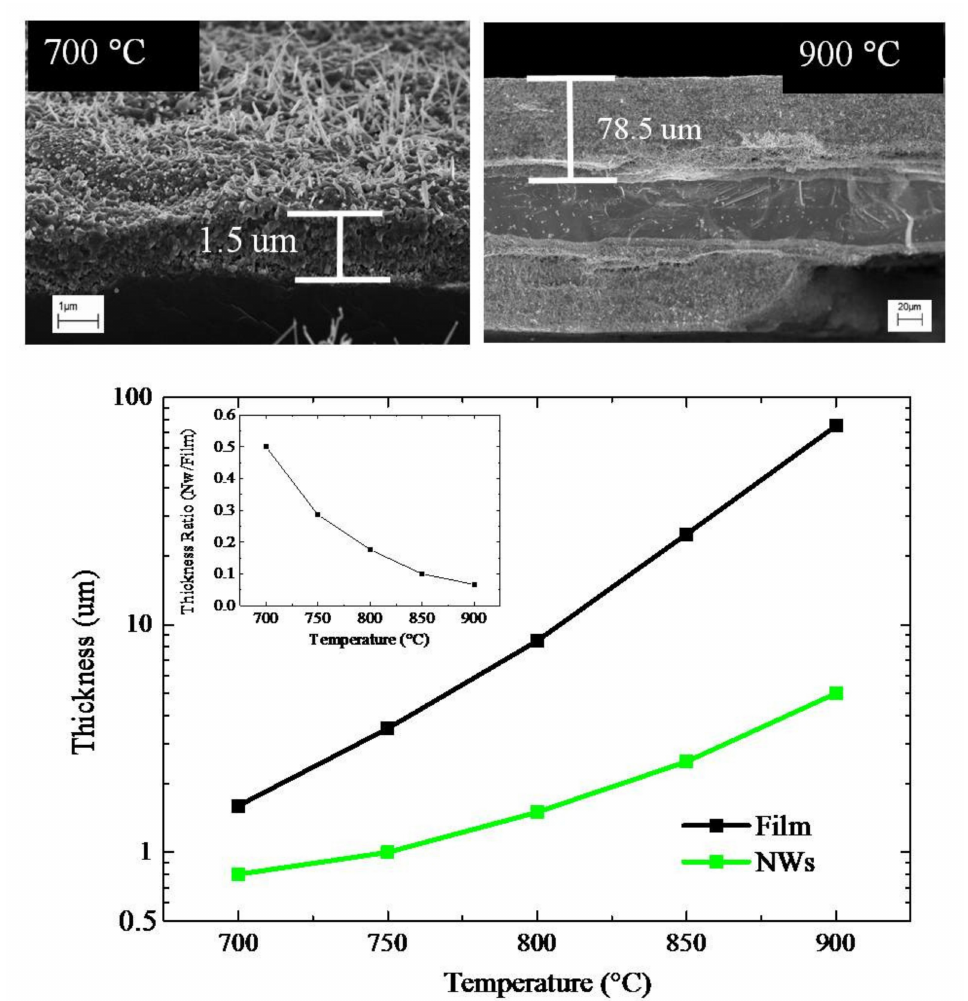
Figure 3. SEM images in cross-view of the samples annealed at 700 and 900 ◦ C ( top ). The thickness of the underneath layer and the length of the nanowires as a function of annealing temperatures for an annealing time of 4 h ( bottom ). The inset reports the ratio between nanowires length and interlayer thickness as a function of the annealing